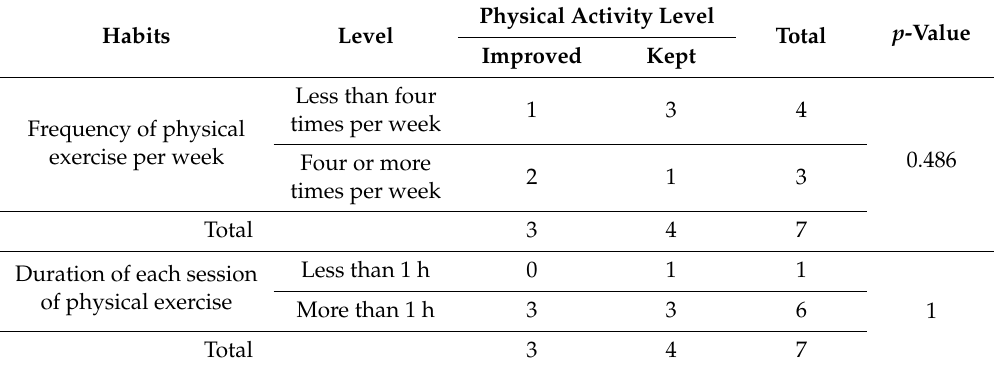
Table 5. Analysis of physical activity habits.